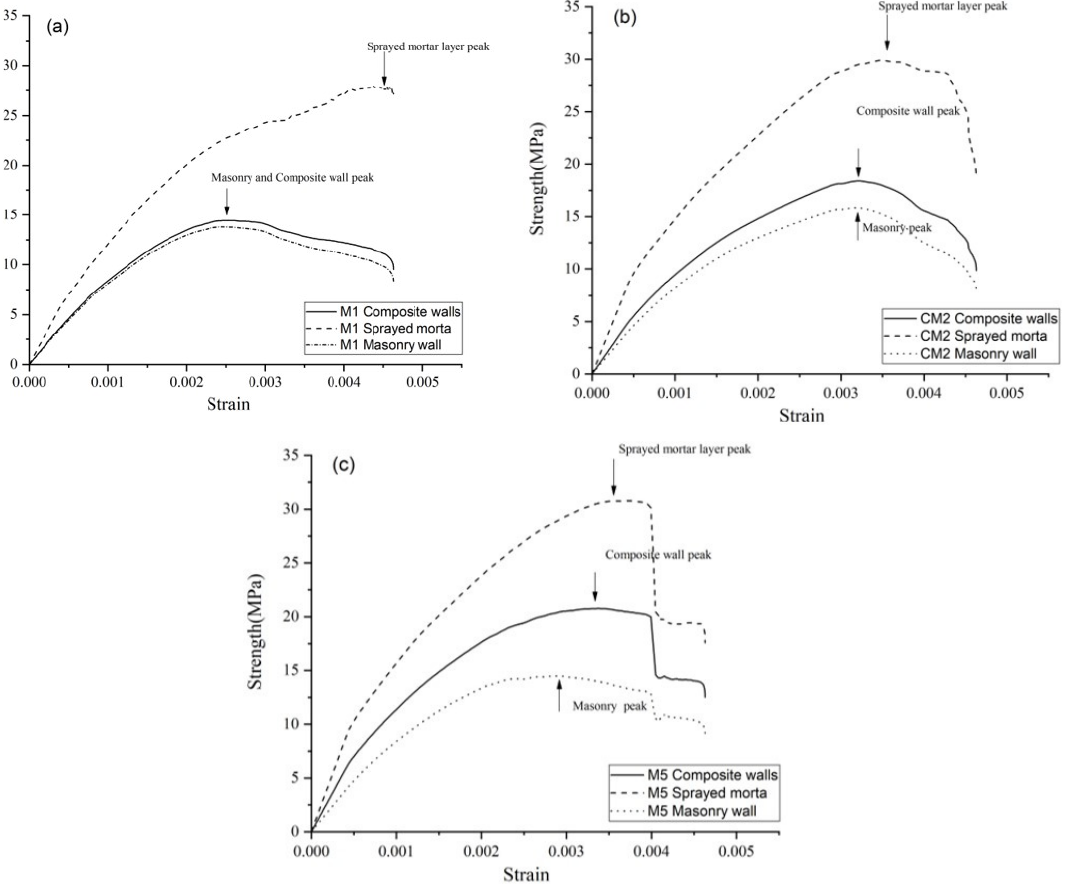
Figure 19. Comparison of stress-strain curve from FE numerical; ( a ) M1, 10 mm sprayed layer sample; ( b ) CM2,30 mm sprayed layer sample; ( c ) M5,90 mm sprayed layer sample ( b ) CM2,30 mm sprayed layer sample; ( c ) M5,90 mm sprayed layer